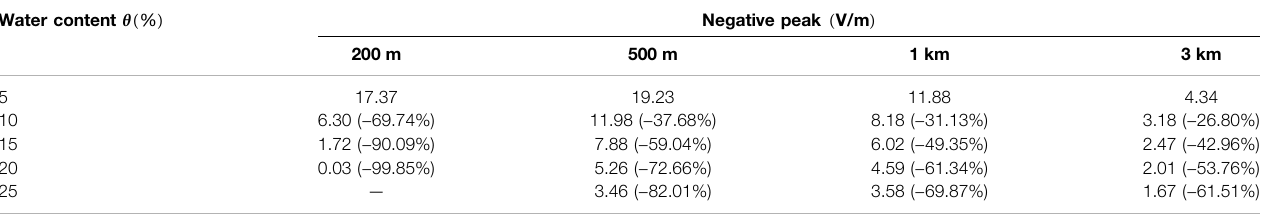
TABLE 5 | Same as Table 4 but for negative peak values of the horizontal electric fi eld (Er) for different water contents θ at different distances d (cid:2) 200m, 500m, 1km, and 3km from the lightning channel. Water content θ ( % )